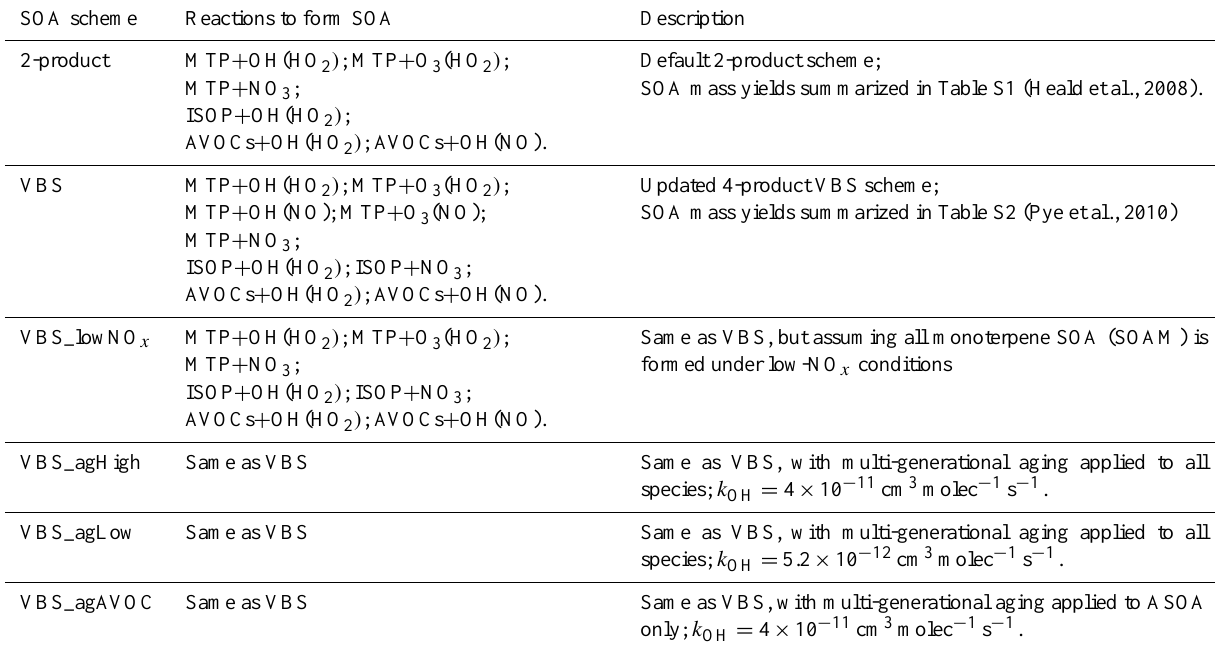
Table 2. Summary of SOA treatments in CAM4-chem model runs. SOA scheme Reactions to form